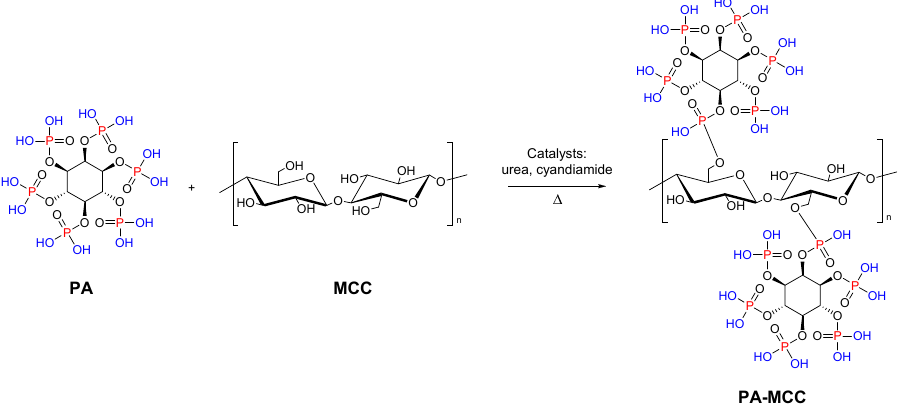
Figure 8. Synthesis of MCC modified with PA.